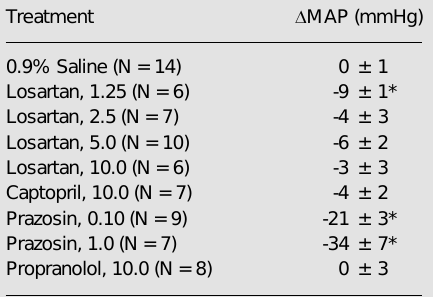
Table 1. Peak variation in mean arterial pressure ( (cid:1) MAP) after intravenous injections of 0.9% sa- line, losartan, captopril, prazosin or